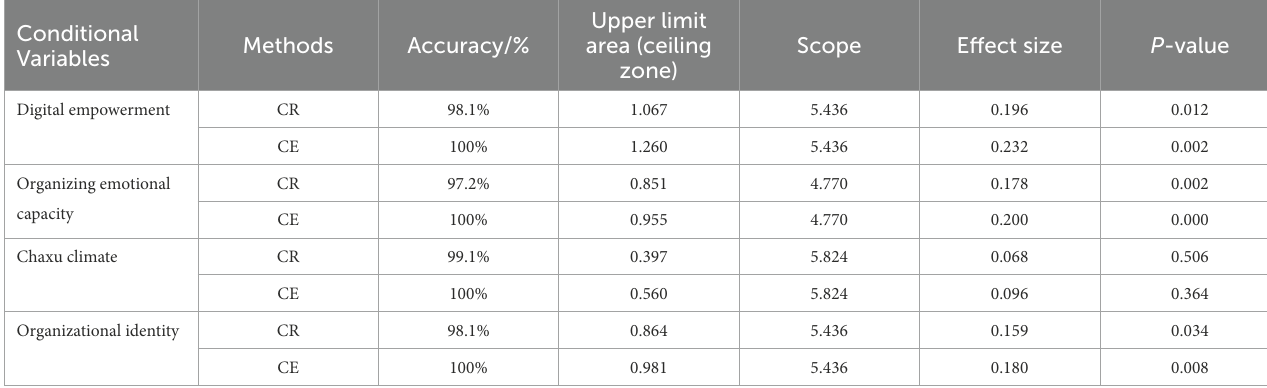
TABLE 8 NCA method single essential condition analysis results.